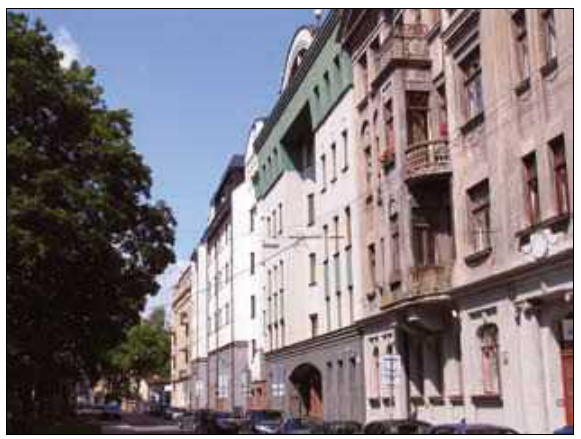
6 pav. Dau­giabu­čių gyvenamųjų namų kompleksas su­ komercinėmis patalpomis teatro g. (archit. a­. blotnys) Fig. 6. block of flats with the commercial premises in teatras st. a­rch. a­. blotnys